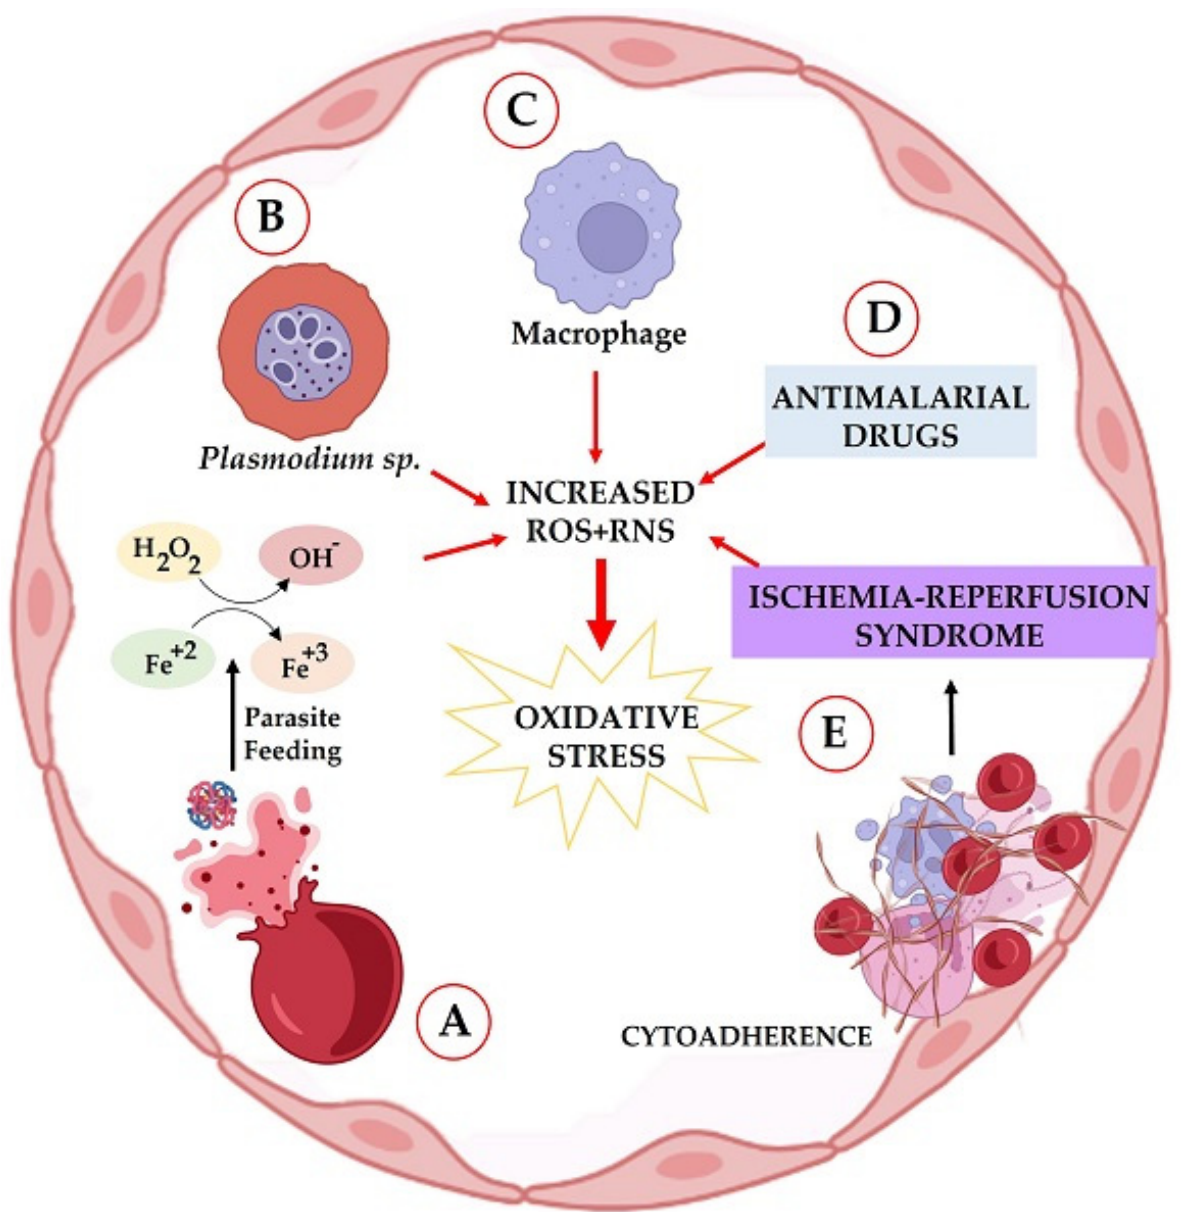
Figure 1. Sources of oxidative stress in malaria. A = Free-iron-induced oxidative stress (OS), as a consequence of hemoglobin digestion by the parasite and through the Fenton or Haber–Weiss reactions; C = direct ROS/RNS production by the parasite; B = host’s inflammatory response-derived oxidative stress; D = production of ROS/RNS by antimalarial drug metabolism; E = cytoadherence- and/or anemia-derived oxidative stress, through ischemia-reperfusion syndrome. ROS = Reactive oxygen species; RNS = reactive nitrogen species.